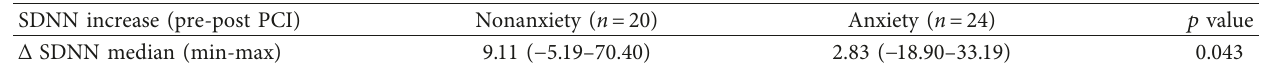
Table 4: Increased SDNN following elective